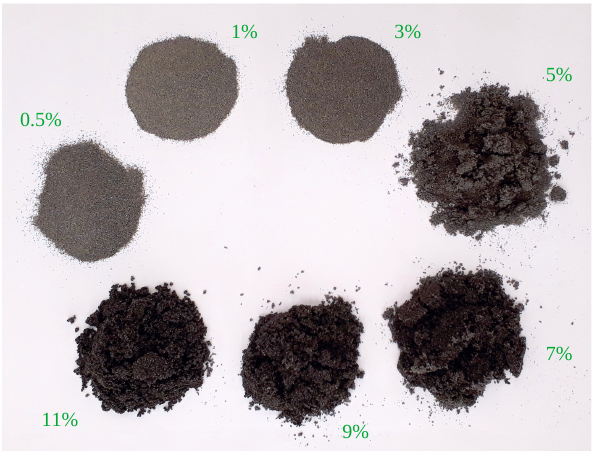
Figure 4. Samples of 0.1–0.2 mm copper ore at different moisture